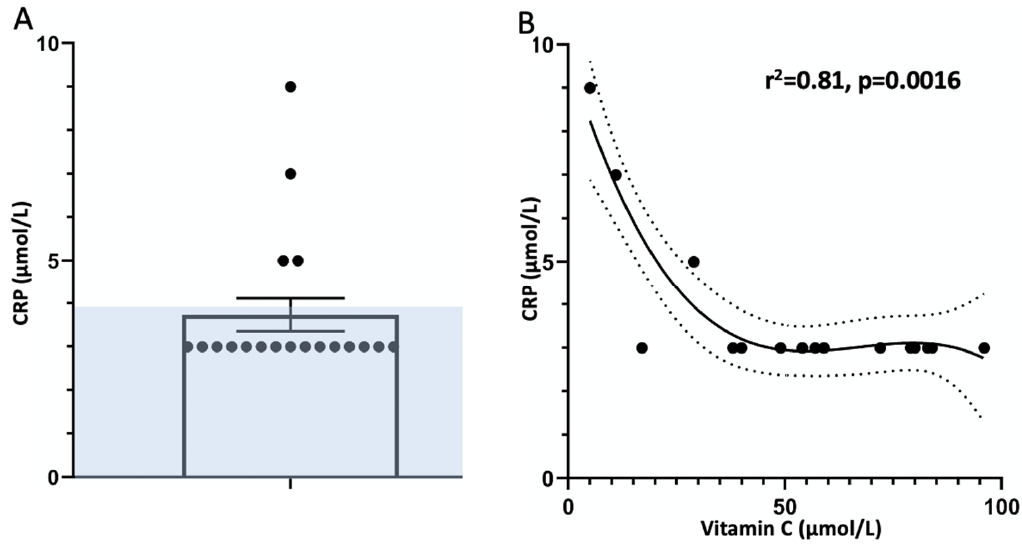
Figure 3. CRP (C-reactive protein) in periodontal patients. ( A ) Individual CRP results, excluding the patient with Crohn’s disease whose level was 32 µ mol / L. Normal CRP was reported as < 4 µ mol / L so these were entered as 3 µ mol / L. ( B ) Correlation between vitamin C and CRP. r 2 = 0.81, p = 0.0016.